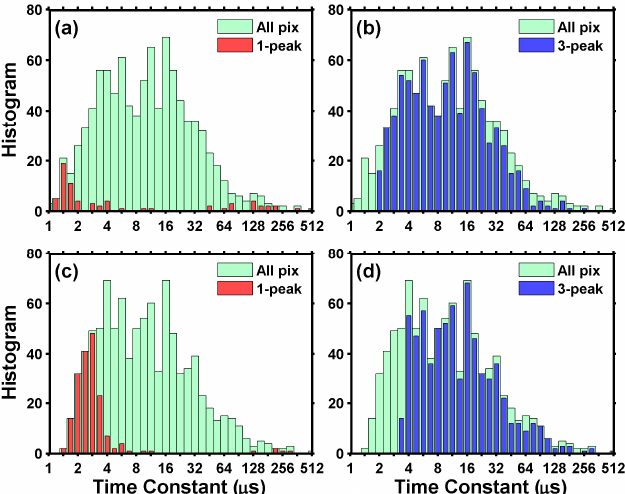
Figure 15. ( a , b ) The extracted RTN time constants distribution under 1X gain for the noisiest 1000 pixels; ( c , d ) The extracted RTN time constants under 8X gain for the noisiest 1000 pixels. All of the time constants fall within the range from 1 µ s to 500 µ s. Among the noisiest 1000 pixels, 80% of them show 3 peaks, and 15% show 1 peak. The time constant of the 1 peak pixels tend to be shorter than the 3 peak pixels.